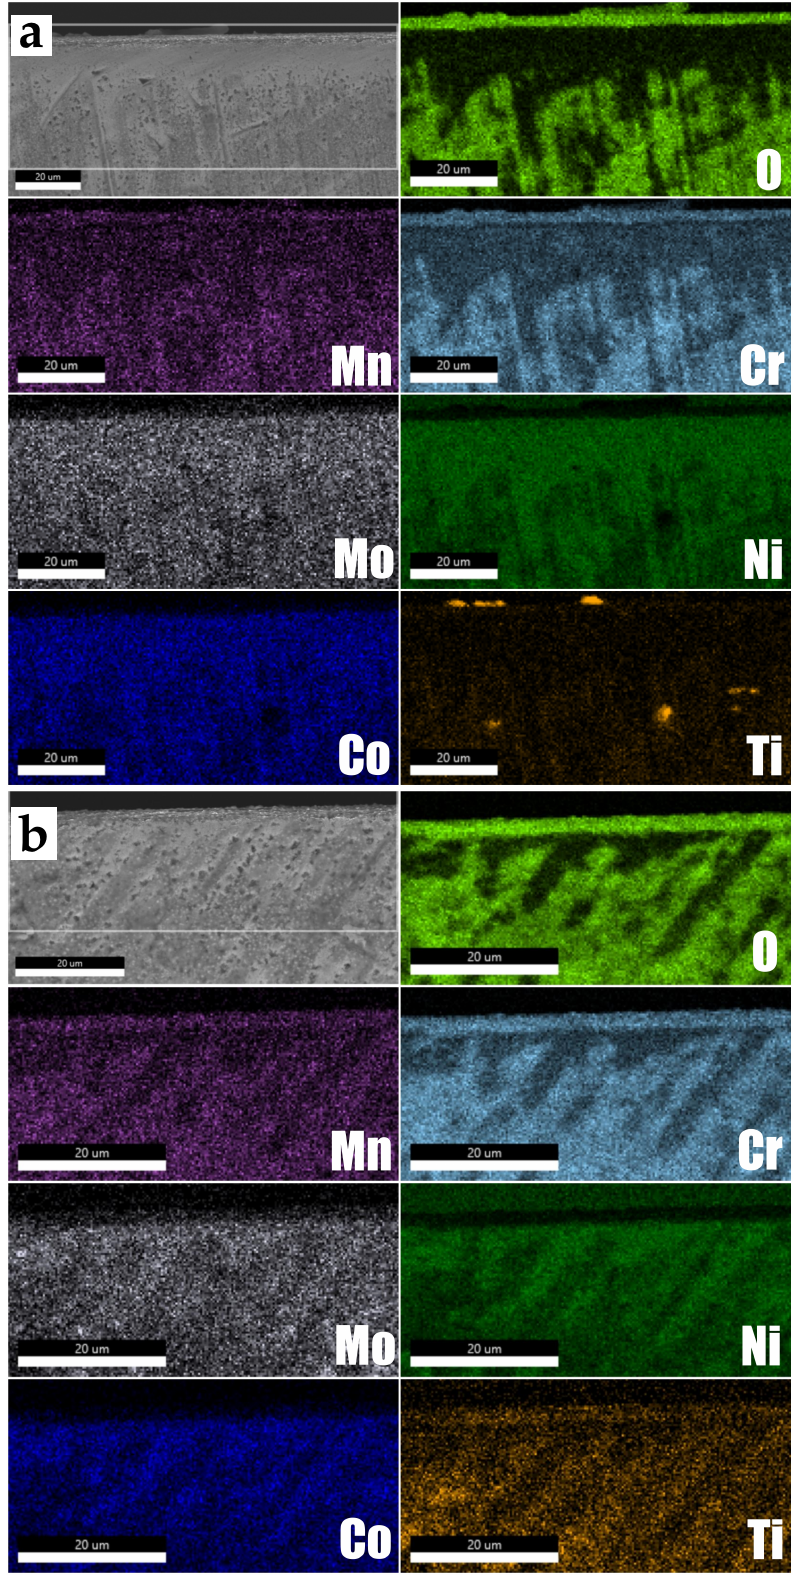
Figure 7. Cross-section SEM micrograph post-air-oxidation of: ( a ) IN 617 AR; ( b ) IN 617